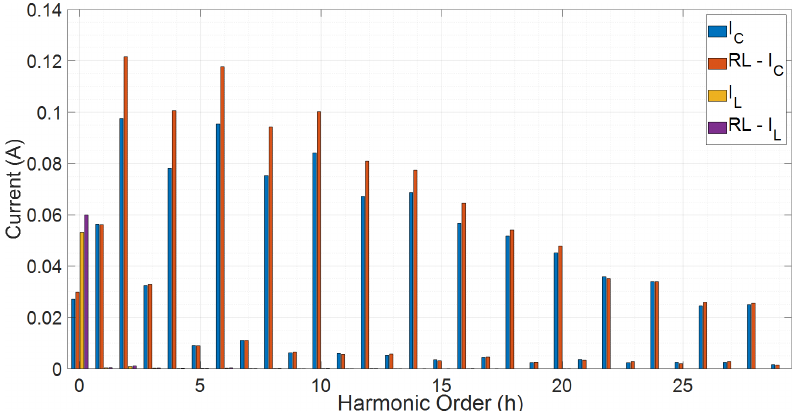
Figure 7. FFT Comparison of the Full and Representative